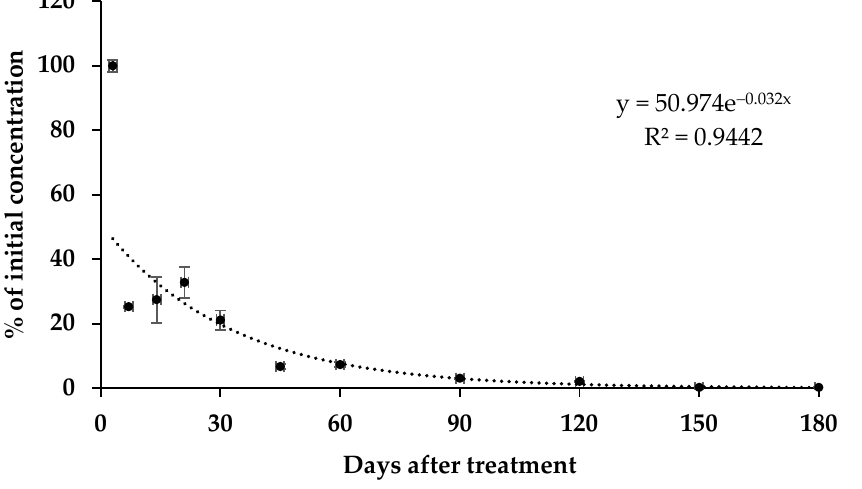
Figure 1. The pattern of diazinon dissipation in soil. Data are means ± standard deviation (SD) of triplicate.